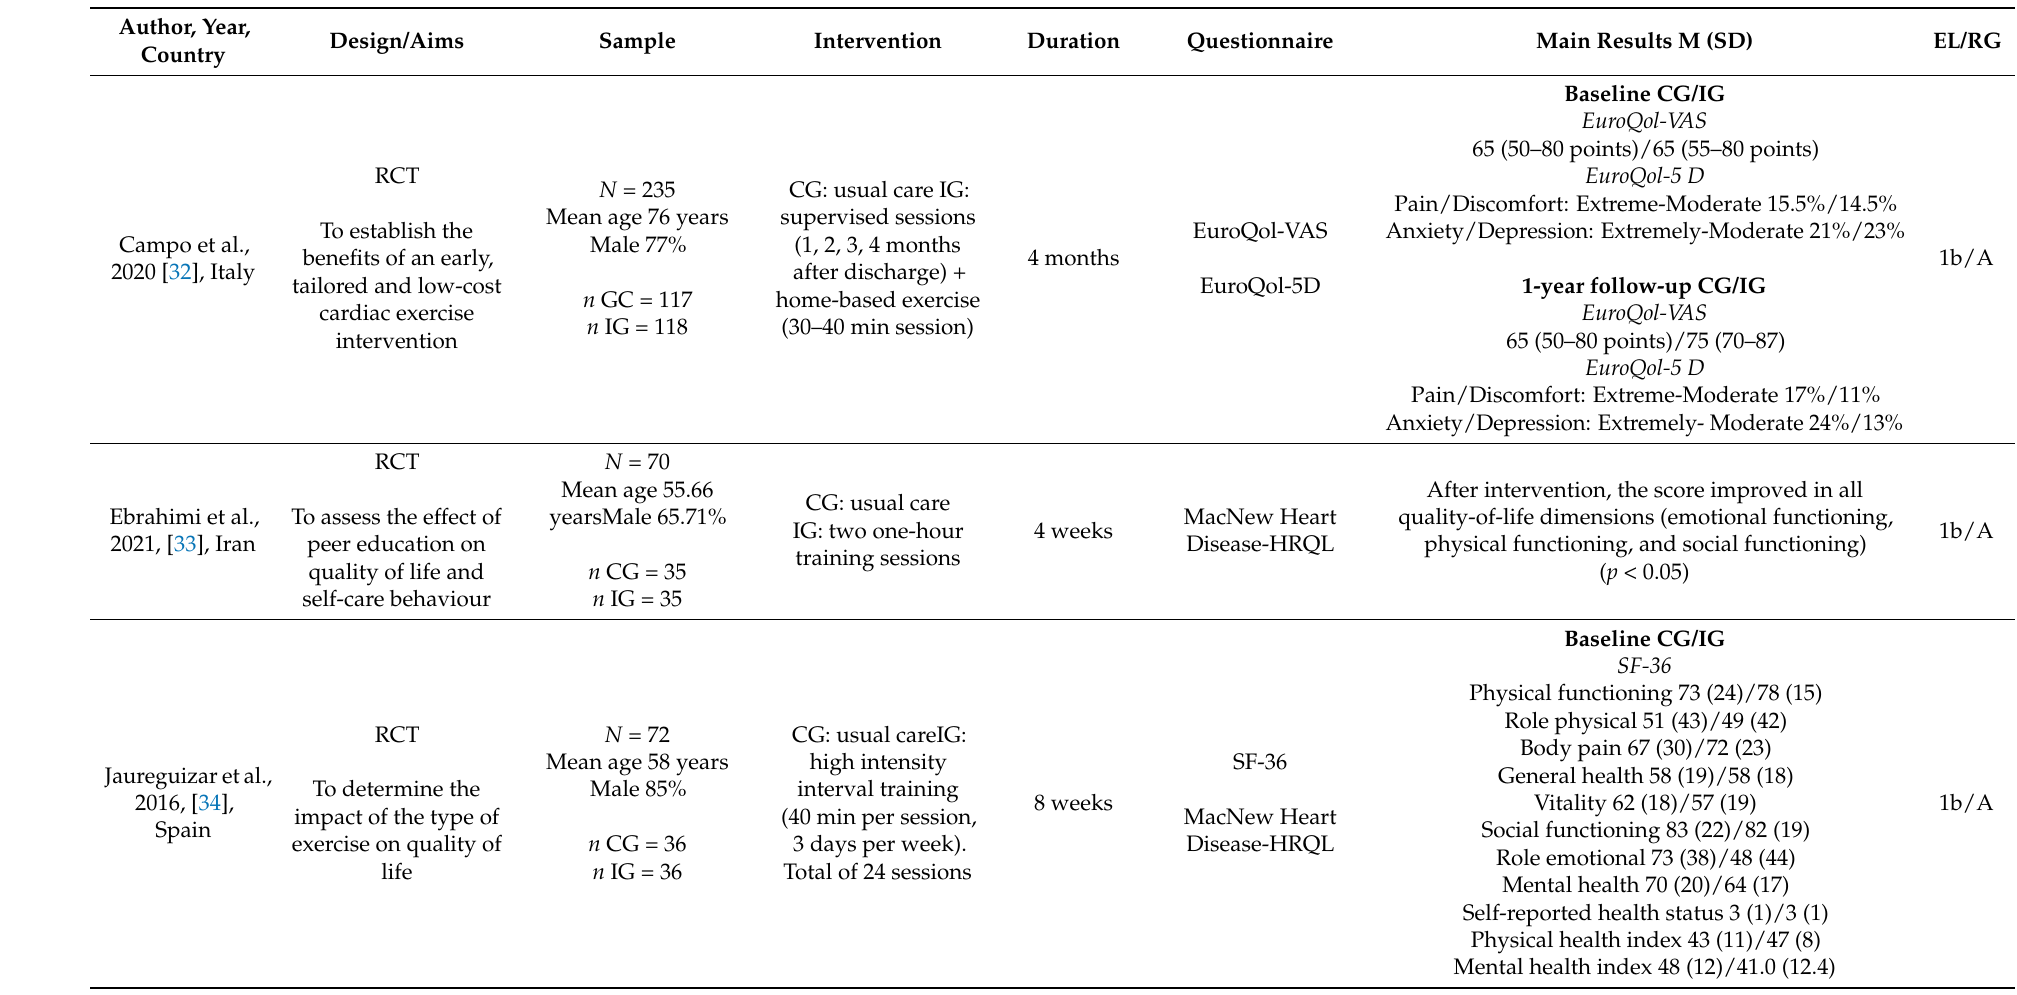
Table 1. Characteristics of the included studies ( n =